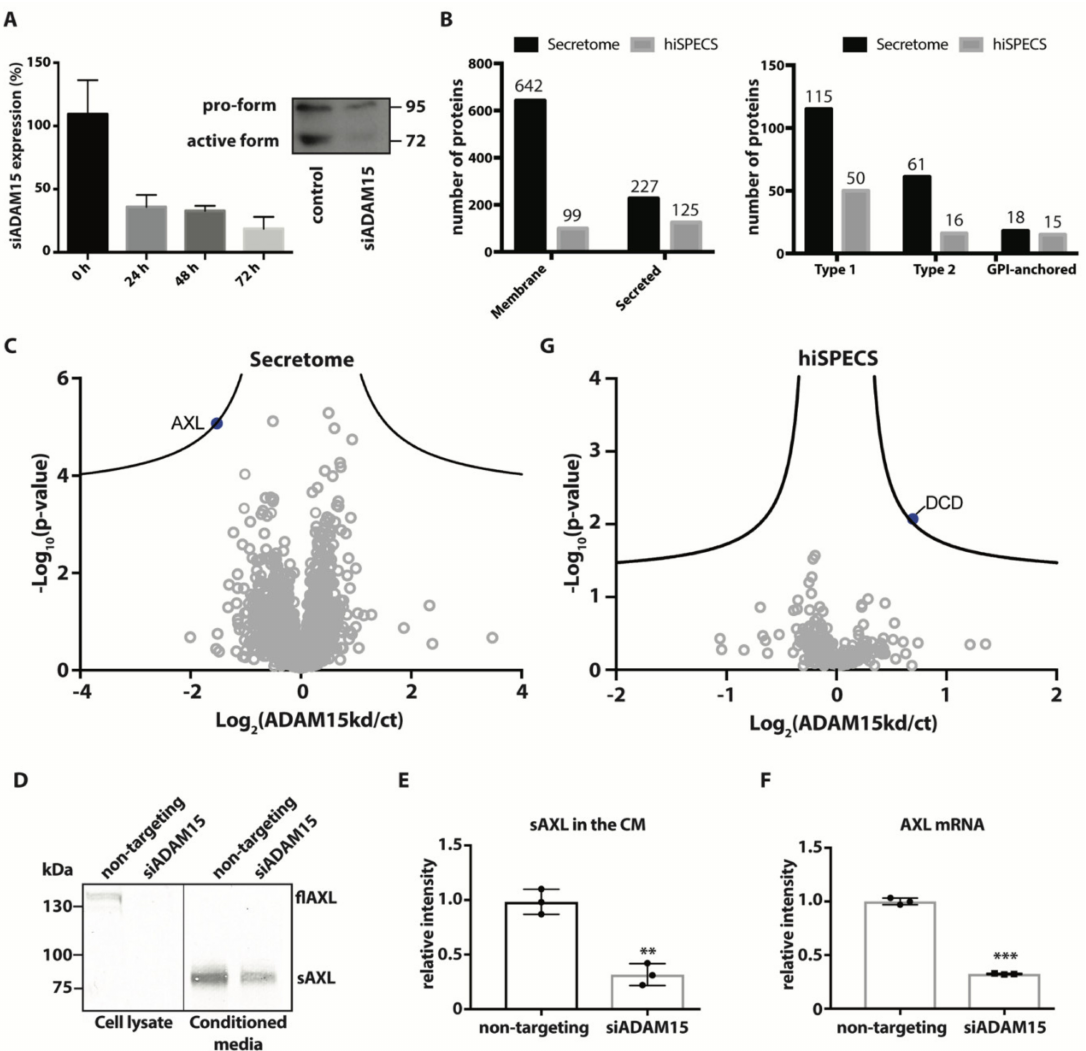
Figure 1. Secretome analysis of ADAM15 knockdown HTB84 cells. ( A ) HTB94 cells were transfected with 20 nM siRNA targeting ADAM15 (siADAM15) or same concentration of non-targeting control RNA (NT). ADAM15 expression was measured by qPCR at 0, 24, 48, and 72 h after treatment with ADAM15 or NT siRNAs, and displayed as a percentage of ADAM15 expression in cells transfected with NT siRNAs at each time point. Protein levels of ADAM15 in HTB94 cells treated with NT siRNAs (control) or ADAM15 siRNAs were analysed by immunoblotting at 72 h (insert). ( B ) Number of proteins annotated as a membrane or secreted proteins identified by secretome analysis or hiSPECS analysis in the conditioned media of ADAM15 knockdown HTB94 cells (left). Topology of single-span membrane proteins detected by secretome or SPECS analysis in the conditioned media of ADAM15 knockdown cells (right). ( C ) Volcano plot showing the − log 10 of p -values versus the log 2 of protein ratio between ADAM15 KD and HTB94 control cells (ct) of proteins detected in the conditioned media by serum-free secretome analysis (n = 6). AXL, which is the only protein above the FDR curves (displayed as black hyperbolic curves) is displayed as a blue solid dot, while proteins below the FDR are displayed by grey open dots. ( D ) Protein levels of full-length AXL in the cell lysates (flAXL) or shed AXL conditioned media (sAXL) of HTB94 cells treated with non-targeting or ADAM15 siRNAs (siADAM15) cells analysed by immunoblotting. ( E ) Bands corresponding to sAXL in the conditioned media from 3 independent experiments were quantified and normalized to the mean of sAXL values in conditioned media of cells treated with non-targeting siRNAs. A two-sided Student’s t -test was used to statistically evaluate changes in sAXL (** p < 0.01). ( F ) AXL mRNA expression levels in